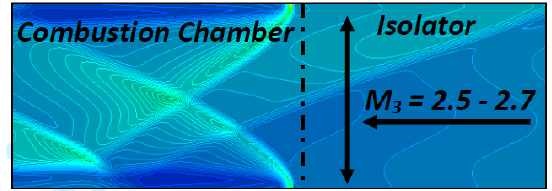
Figure 29. Isolator-injector shockwave interaction.